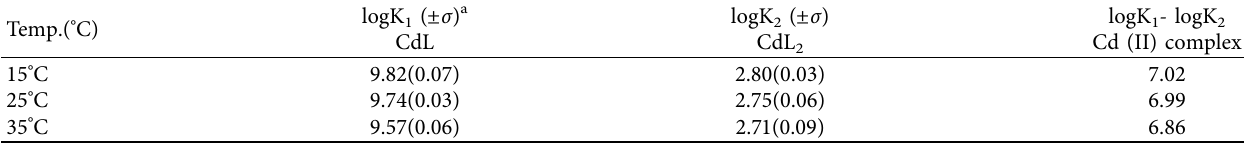
2 O (V/V) solution.